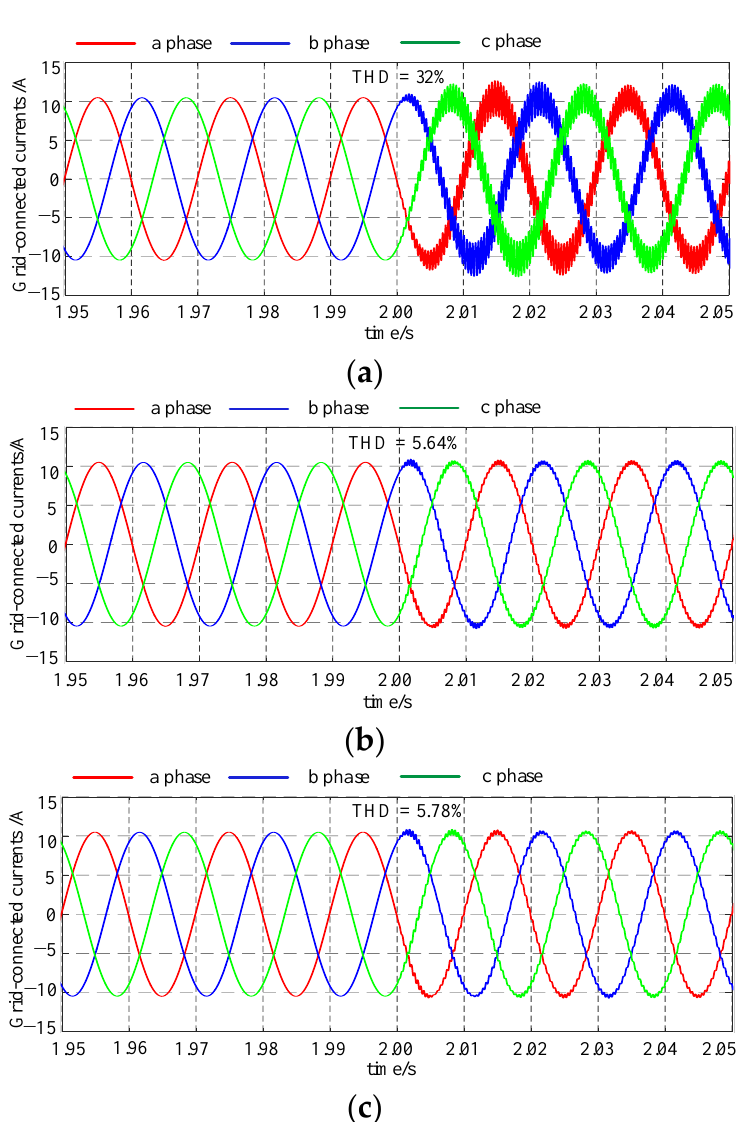
Figure 16. Current waveform of a single VSG injected with 2.3 kHz harmonic voltage. ( a ) A harmonic voltage of 2.3 kHz injected. ( b ) A harmonic voltage of 2.1 kHz injected. ( c ) A harmonic voltage of 2.5 kHz injected.